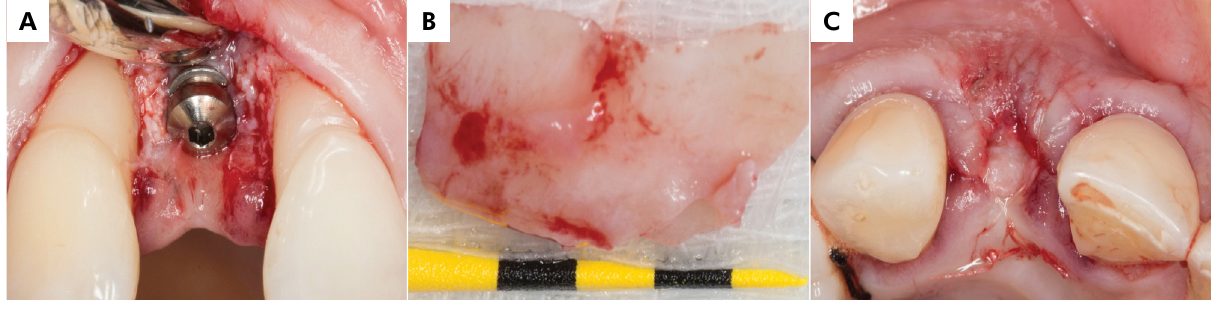
Figure 9. There was a small bone defect at the facial and interproximal aspects (a). A thick CTG (b) was harvested from the palate and placed at the implant site facial and occlusal aspects (c).